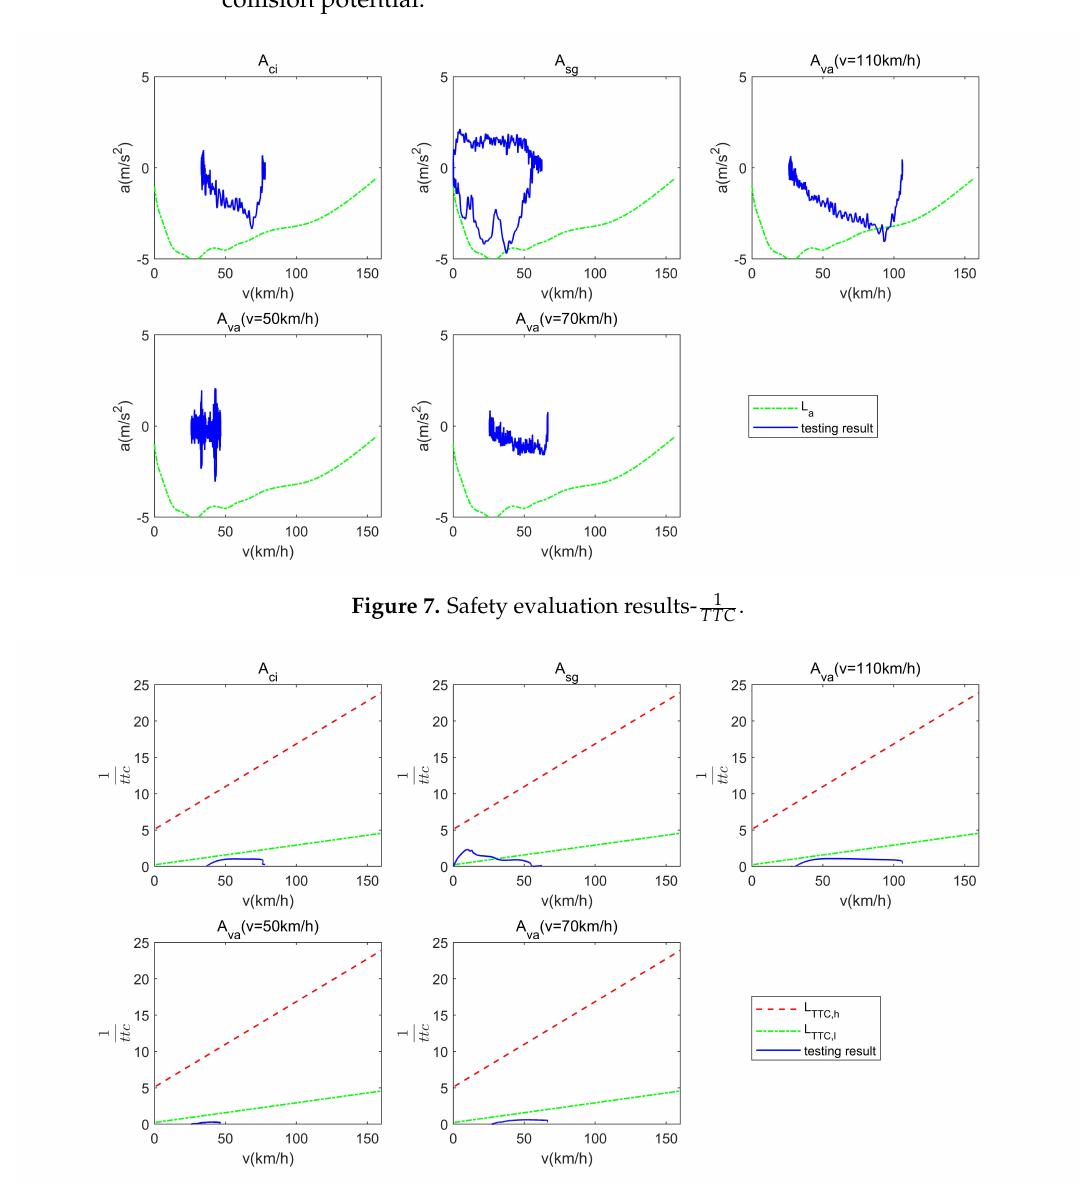
Figure 8. Safety evaluation results- a